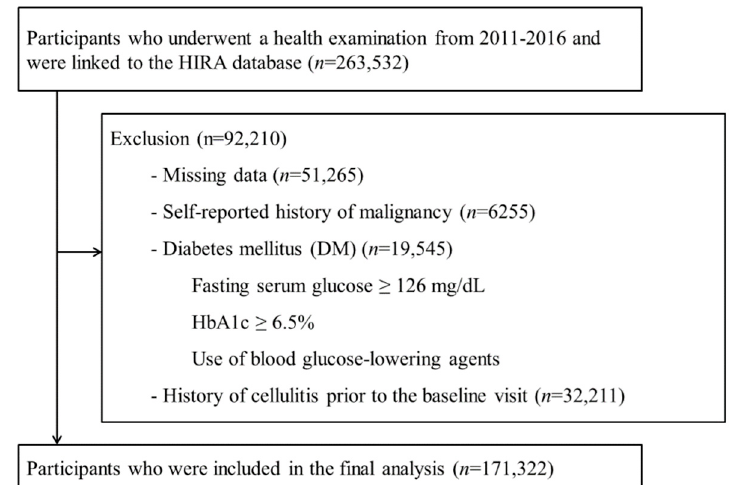
Figure 1. Selection of the study population. HIRA = Health Insurance Review and Assessment Service.